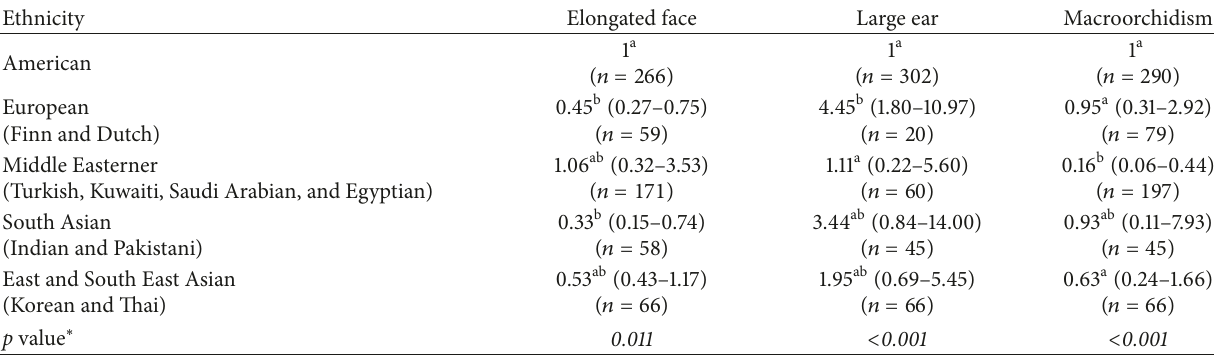
Table 3: Logistic regression analysis showing relationship between ethnicity and main physical characteristics, regardless of pubertal status. Odds ratio and 95% confidence interval for each characteristic are